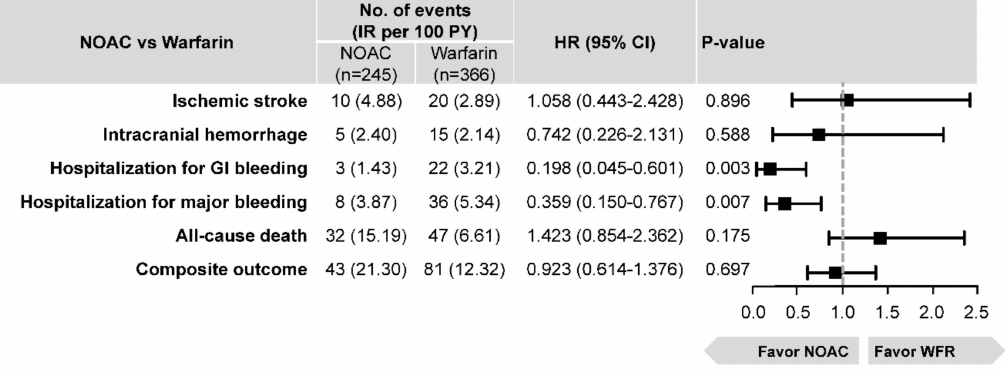
Figure 5. Event numbers, crude incidence rates, and HRs of six clinical outcomes with pooled NOAC versus warfarin (reference) using multivariate Cox regression analysis in patients with EHRA type 1 VHDs. The NOAC group showed a comparable risk of ischemic stroke, ICH, all-cause death, andcompositeoutcome.InhospitalizationforGIbleedingandmajorbleeding, NOACusewasassociated with a significantly lower risk compared to the use of warfarin. Abbreviations: CI, confidence interval; EHRA, Evaluated Heartvalves, Rheumatic or Artificial; GI, gastrointestinal; HR, hazard ratio; ICH, intracranial hemorrhage; NOAC, non-vitamin K antagonist oral